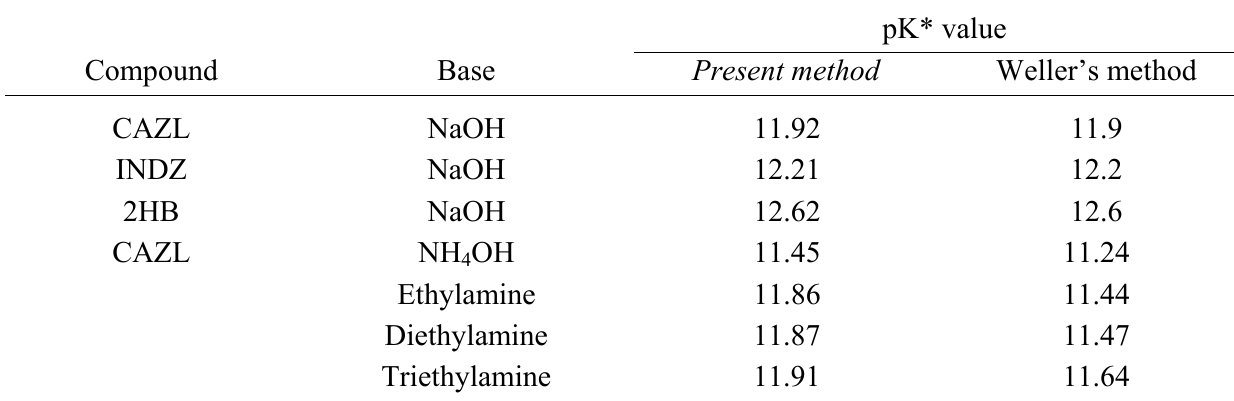
Table 1. Steady state pK* values determined in aqueous